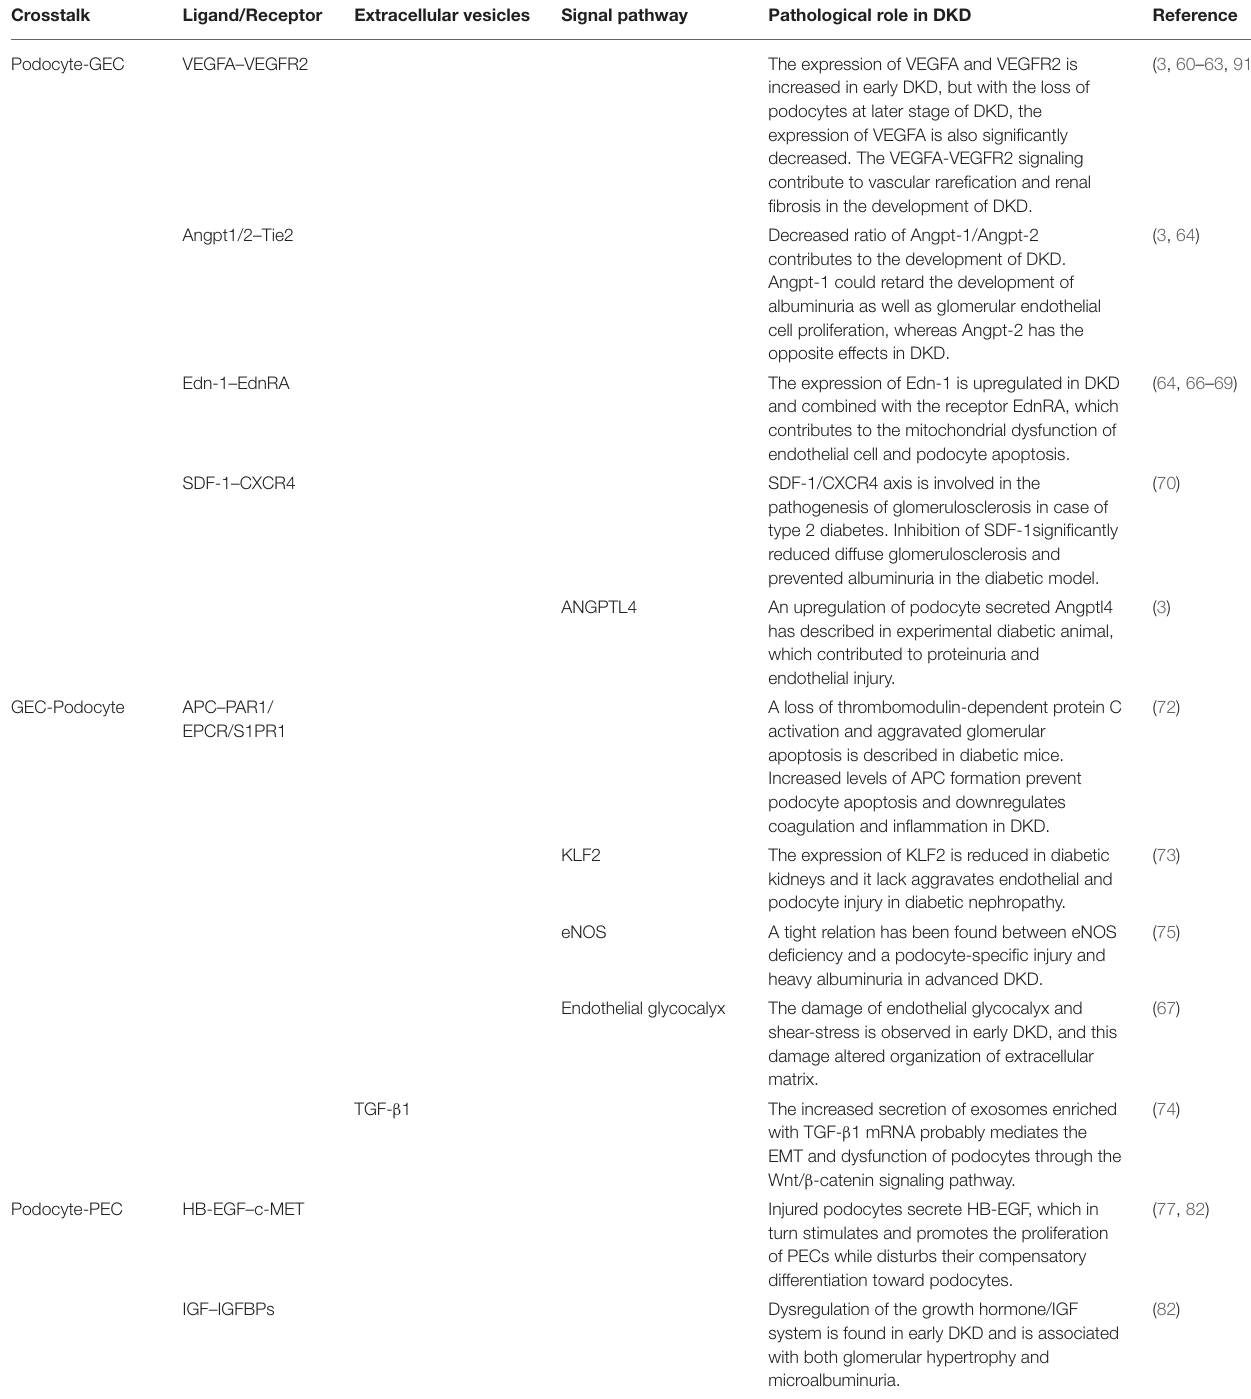
TABLE 1 | Summary of the mediators for intraglomerular crosstalk in